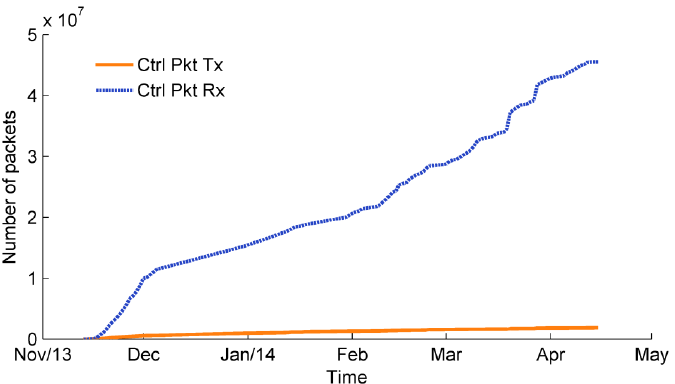
Figure 11. The cumulative number of network-level control packet (Ctrl Pkt) transmissions (Tx) and receptions (Rx) during the CTP evaluation period.